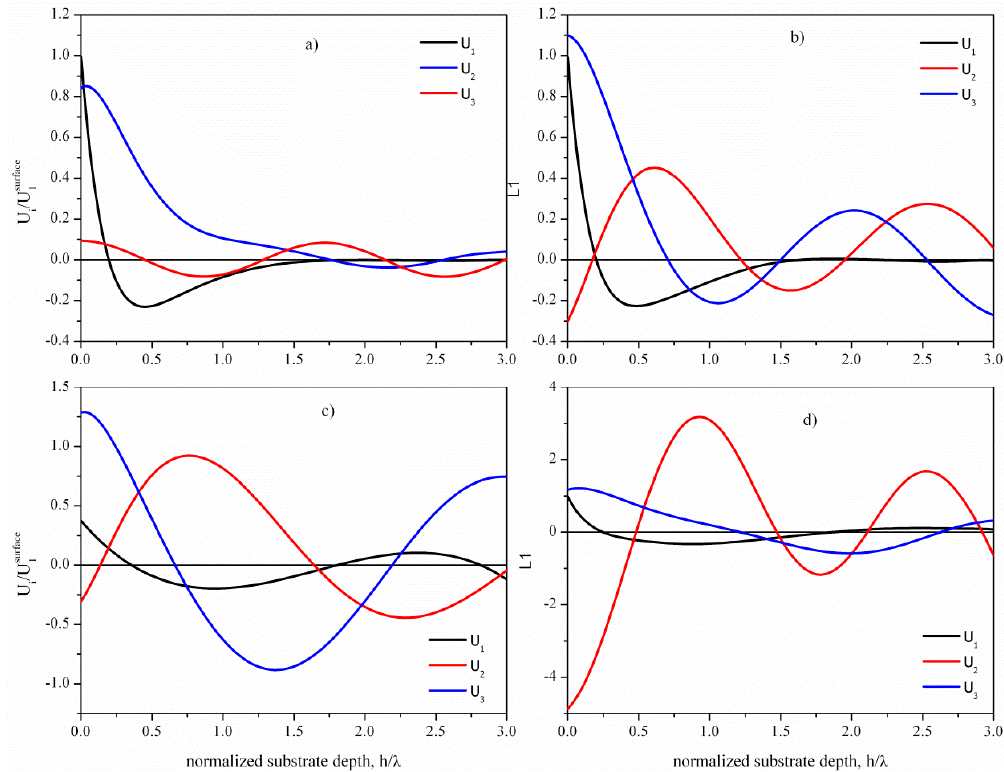
Figure 8. The field profile of the pseudo SAW travelling at: 0°( a ); 10 ( b ); 20° ( c ) and 25° ( d ) off the <110> direction of the (111) plane of 3C-SiC.